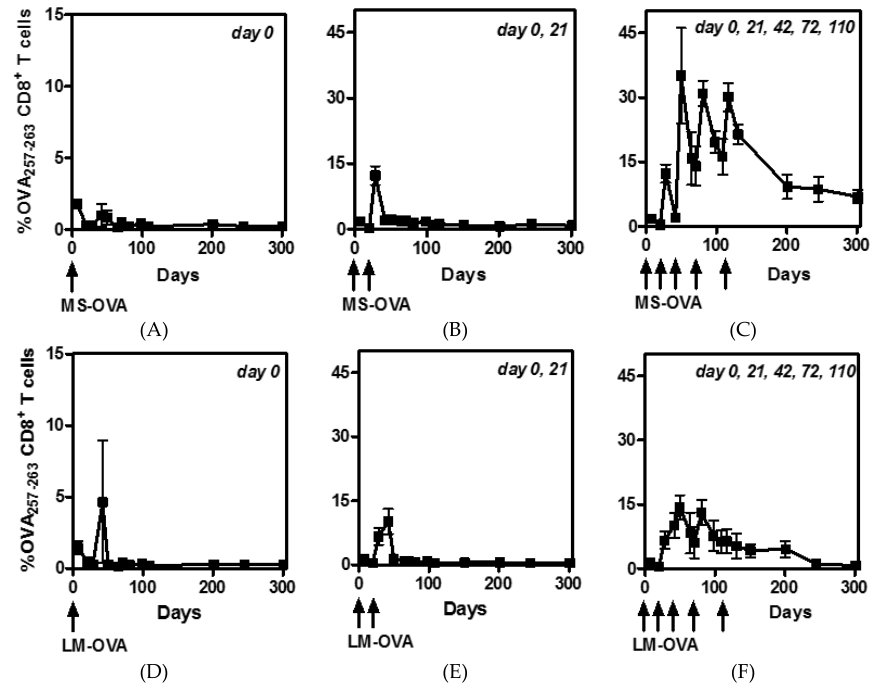
Figure 1. CD8 + T cell frequency following prime-boost vaccinations with MS-OVA or LM-OVA. C56BL/6 mice were vaccinated by s.c. injection with 20 µg of MS-OVA (panels ( A ), ( B ), ( C )) or 10 4 LM-OVA (panels ( D ), ( E ), ( F )) in the middle of the dorsal flank either once, twice or five times (day 0, 21, 42, 72, 110) as indicated at the top of each panel. Blood was taken before vaccination, seven days after and 21 days after each vaccination as well as at later time-points. Blood was stained with anti-CD8 antibody as well as OVA 257–263 tetramer and analyzed by flow cytometry. n = 3/time